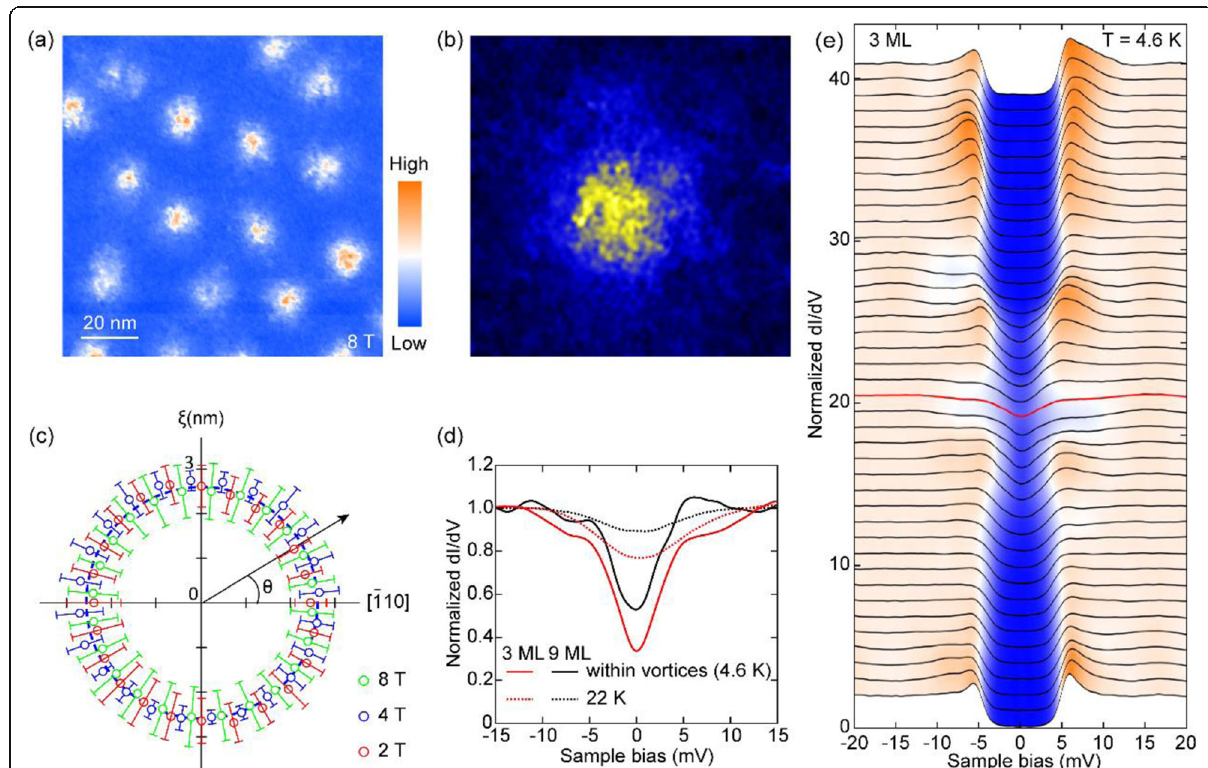
Fig. 10 Vortex states in 3 ML K 3 C 60 . ( a ) Zero energy conductance map under a magnetic field of 8 T. ( b ) Enlarged images for a typical vortex at zero energy. ( c ) Azimuthal dependence of the fitted coherence length ξ . ( d ) Pseudogaps measured at 22 K and within vortices (measured at 4.6 K). ( e ) d I /d V spectra across a vortex core ( T = 4.6 K and B = 2 T). Taken from ref.